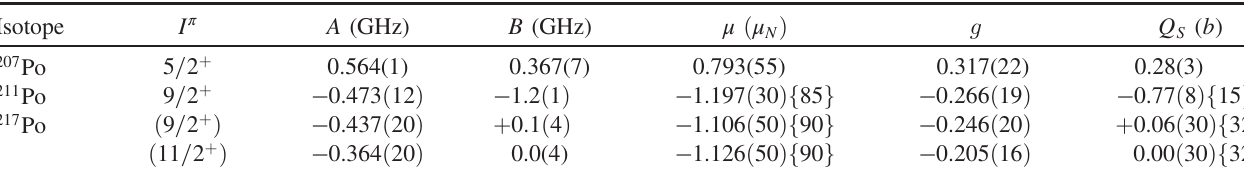
TABLE II. Hyperfine parameters, electromagnetic moments, and g factors of 207 ; 211 ; 217 Po from Ref. [38] (and references therein) and this work, respectively. Statistical uncertainties are given in parentheses, and the total uncertainties including systematic uncertainties originating from the reference isotope 207 Po are given in the curly brackets. For 217 Po, the results for fitting with both I ¼ 9 = 2 and 11 = 2 are presented.